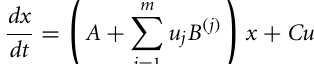
successive numbers alternated (arial, times new roman).This ensured a baseline level of “flicker” between successive presentations, pre-empting target detection based on visual cues such as the absence of